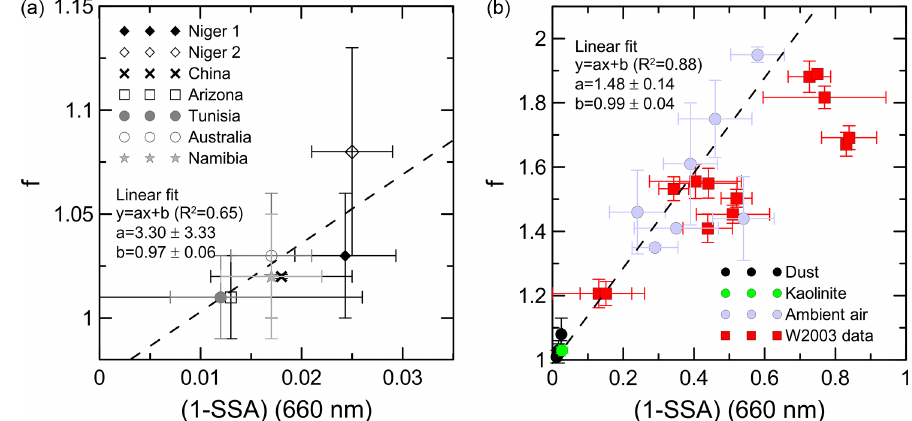
Figure 5. (a) Estimated f values versus (1 − SSA) at 660nm for dust aerosols. Different symbols are used to distinguish between dust from different sources. The uncertainty of (1 − SSA) is the standard deviation over 2min data, while that of f is calculated with the error propagation formula taking into account the uncertainty of a ( ± 0.14) and that of (1 − SSA). (b) f versus SSA at 660nm for all experiments. Different symbols are used to distinguish between different aerosol types. The results of the linear fit between f and (1 − SSA) are also reported. Data from Weingartner et al. (2003) (W2003) (extracted from their Fig. 4) are also shown in the plot for comparison.